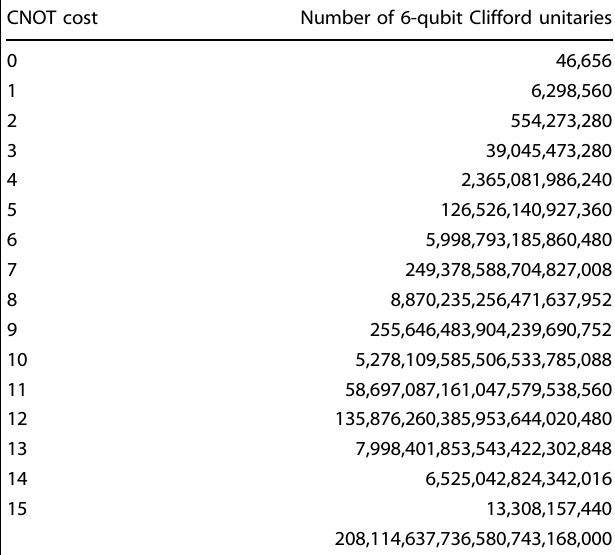
Tableau representation is particularly useful since it allows to de fi ne quantum gates and circuits directly without the need to resort to standard de fi nitions in quantum information that employ 2 n × 2 n unitary matrices 1 . Indeed,